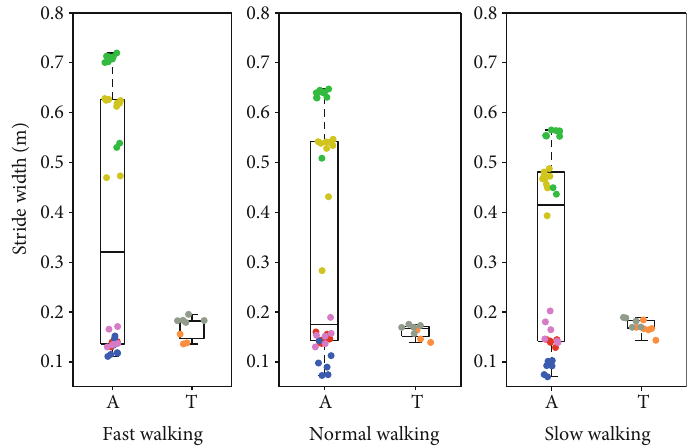
Figure 18: Stride width of participants with intact limbs and prosthesis users at three speeds with the normal speed being their preferred speed. The data from participants with intact limbs is shown on the left (A) and transfemoral prosthesis user data is shown on the right (T) in each pair. The fi gure shows the median, along with a box that bounds the fi rst and third quartiles of the data, and whiskers that bound the entire range of the data (apart from outliers). Moreover, the scatter plot shows the average stride width of each trial. The data for each subject are color-coded: yellow = AB01 , green = AB02 , red = AB03 , blue = AB04 , purple = AB05 , brown = PR01 , and gray = PR02